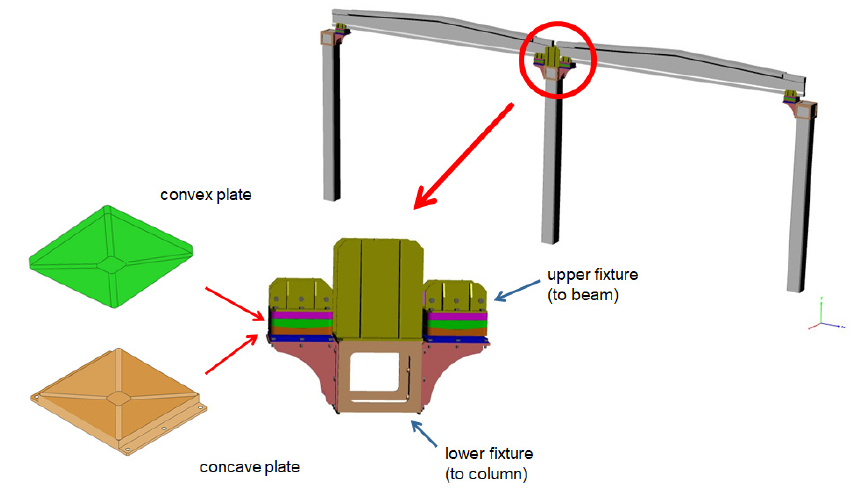
Figure 1. Sketch of the dissipative connection system and typical installation at beam-to-column joint.